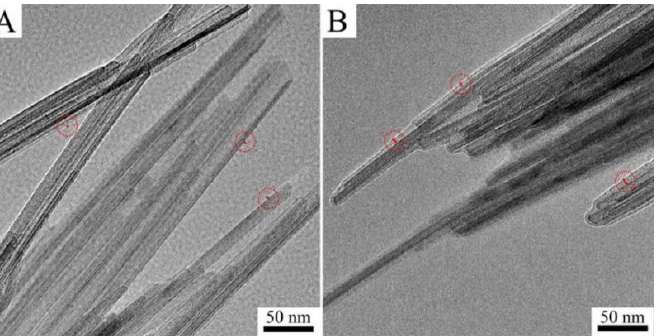
Figure 1. TEM images of the MnO 2 @PSS/PDDA/PSS ( A ) and MnO 2 @(PSS/PDDA) 3 /PSS ( B ).